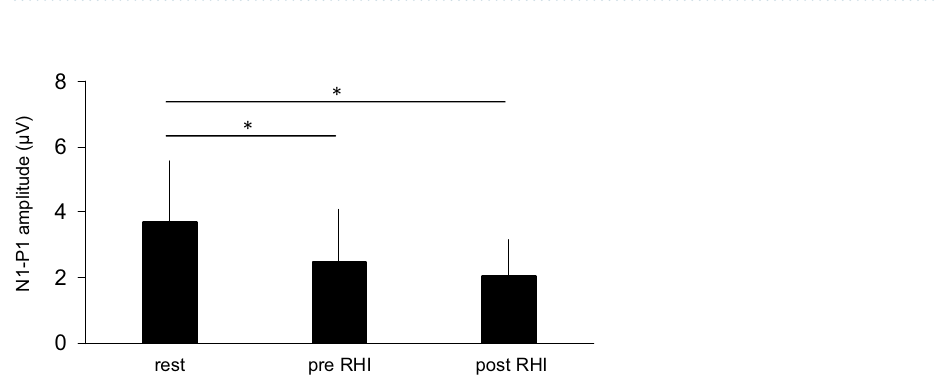
Figure 7. Group means of N1-P1 amplitudes during the rest, pre rubber hand illusion (RHI), and post RHI conditions in Experiment 2. Data are represented as mean ± one SD. * p <